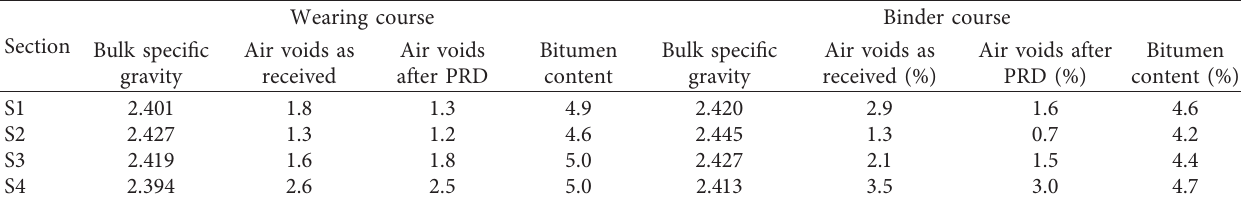
Table 7: Volumetric analysis of the asphaltic surfacing.